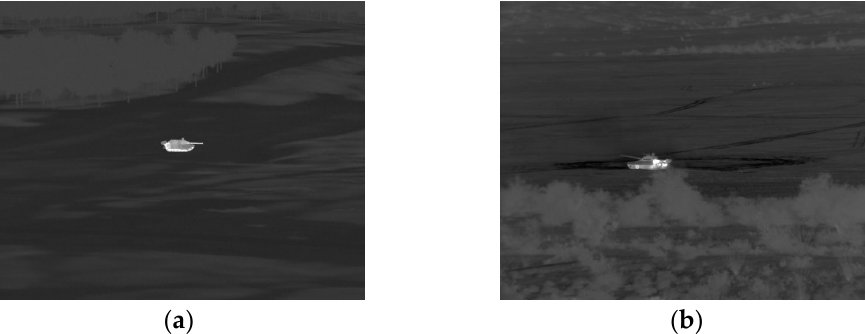
Figure 2. MWIR image examples: ( a ) Simulated infrared image generated with OKTAL-SE [7]; ( b ) Real infrared image from SENSIAC ATR database [32].